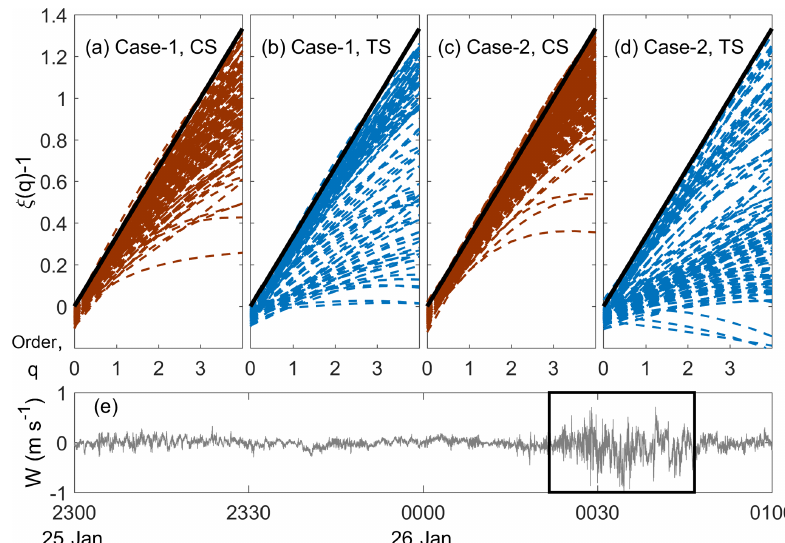
Figure 5. Hilbert-based scaling exponent function at 40m during different stages for Case-1 in (a) and (b) and Case-2 in (c) and (d) , where each dashed curve represents the result of 30min vertical wind speed signal, and the black solid line denotes the K41 result q/ 3. Panel (e) compares vertical wind fluctuation at 40m between the CS (before 00:00 on 26 January 2017) and TS (after 00:00 on 26 January 2017). The latter shows apparent bursts marked by the rectangular frame.